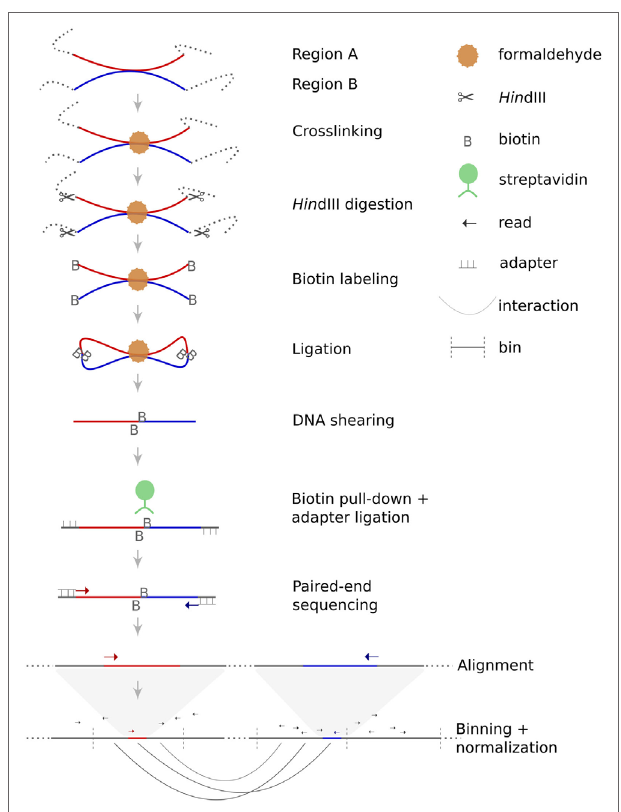
FigUre 1 | Principle of Hi-C. Hi-C is a variant of the chromosome conformation capture assay dedicated to the identification of genome-wide intrachromosomal and interchromosomal interaction probabilities. The method starts with crosslinking of chromatin within the nuclei. Restriction enzyme digestion (in this case HindIII) generates sticky ends which are filled-in and labeled with biotin. During the following ligation step, free DNA ends are re-ligated, which can either restore the original DNA sequence or can lead to chimeric products. The likelihood of such chimeric products depends on their spatial proximity. Afterward, crosslinking is reversed and DNA is sheared. Size selection and pull-down of biotin-labeled fragments are performed to increase specificity. Next, sequencing adapters are ligated to each fragment before sequencing. Finally, paired-end sequences are mapped to the human reference genome to deduce spatial proximities from the frequency of chimeric